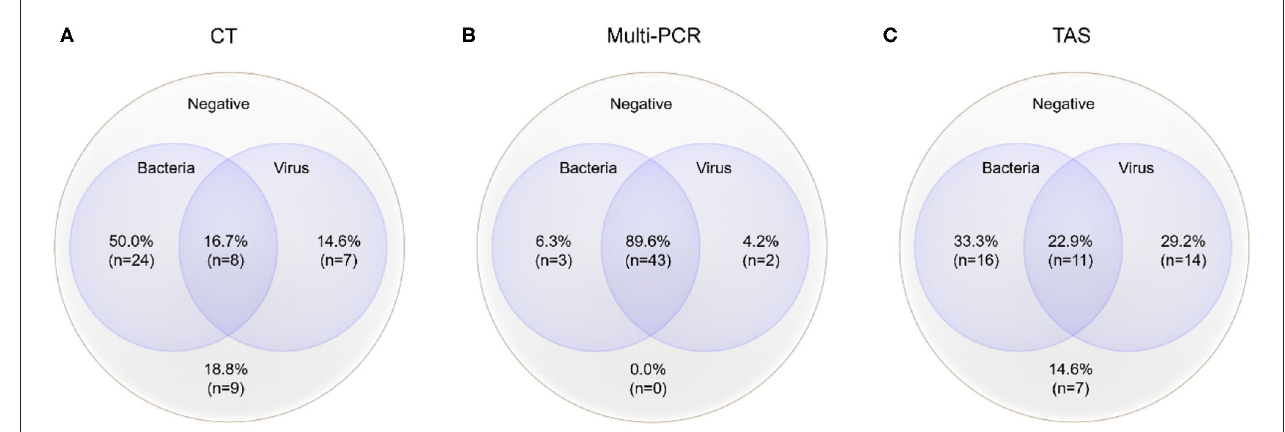
FIGURE 3 | Mixed pathogens detection by three different methods (MP was counted as atypical bacteria); the cross-section refers to the co-detection of viruses and bacteria, excluding the co-detection of different viruses in the same sample. (A) Pathogens detected by CT; (B) Pathogens detected by Multi-PCR; (C) Pathogens detected by